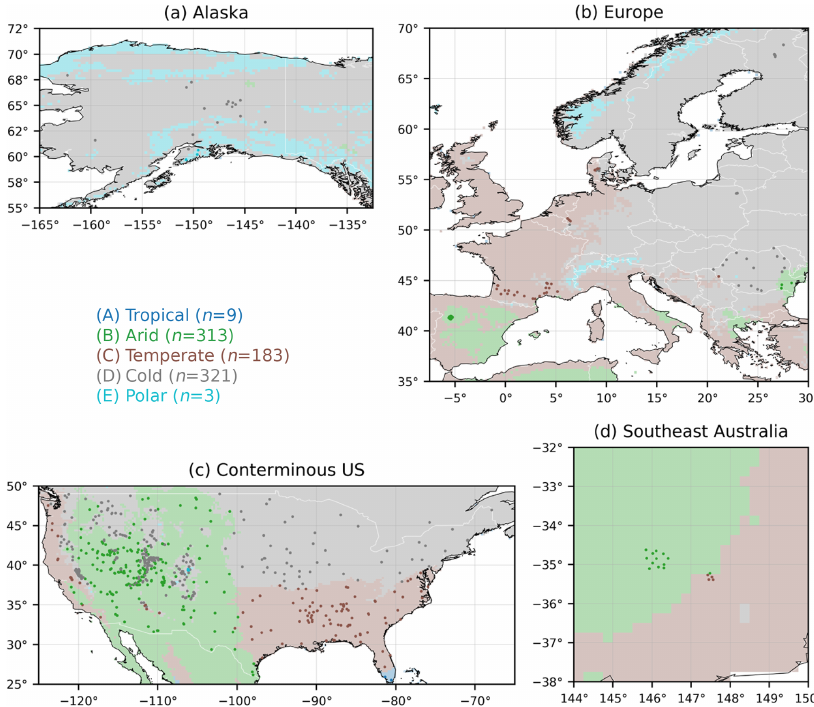
Figure 2. Major Köppen–Geiger climate class (Beck et al., 2018) of the 826 sensors used as reference. n denotes the number of sensors in each